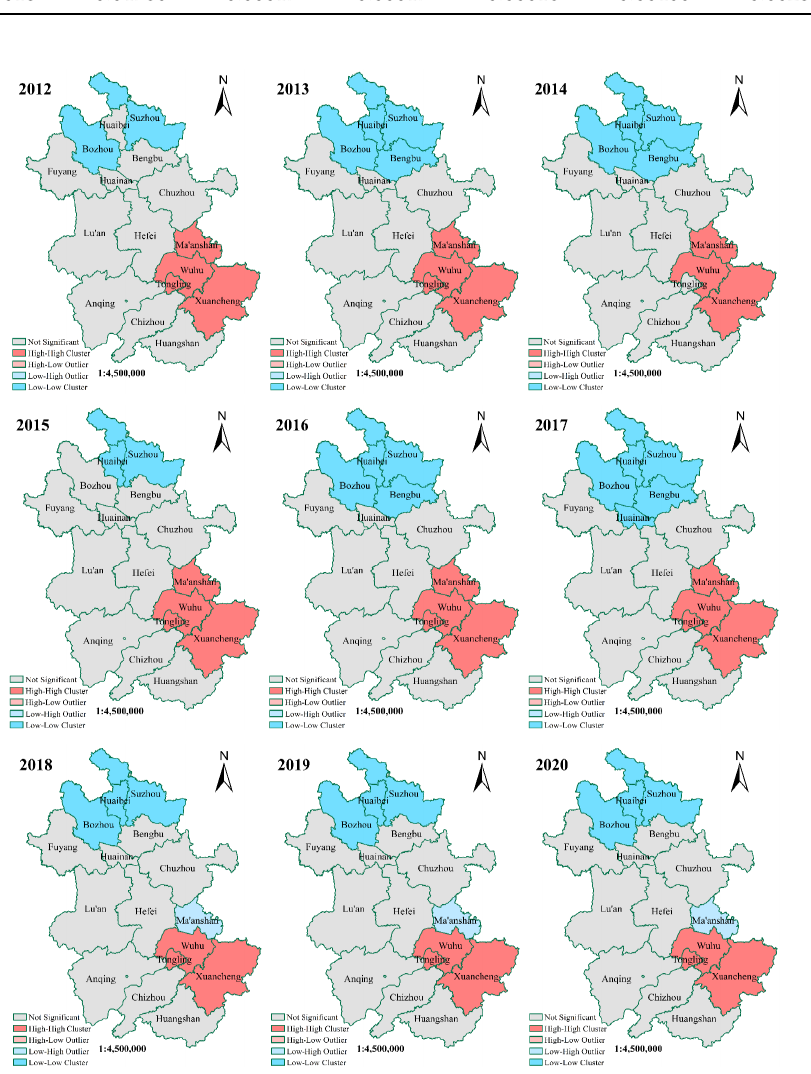
Figure 4. The LISA maps from 2012 to 2020.